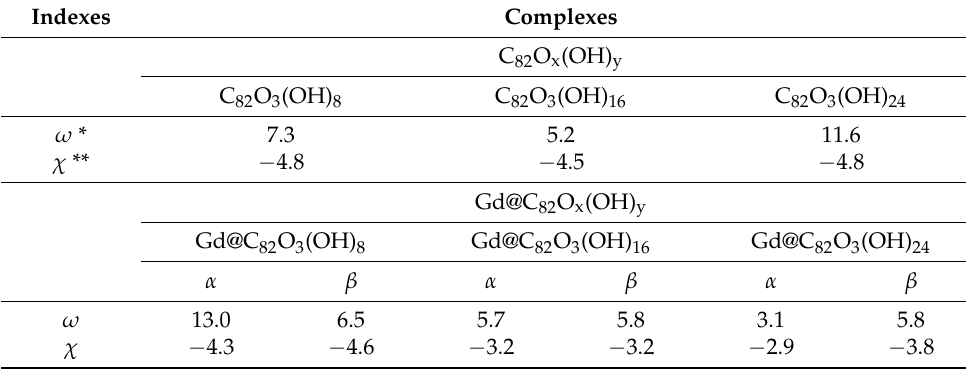
Table 2. Electrophilicity and absolute electronegativity indices of Gd@C 82 O x (OH) y and C 82 O x (OH) y